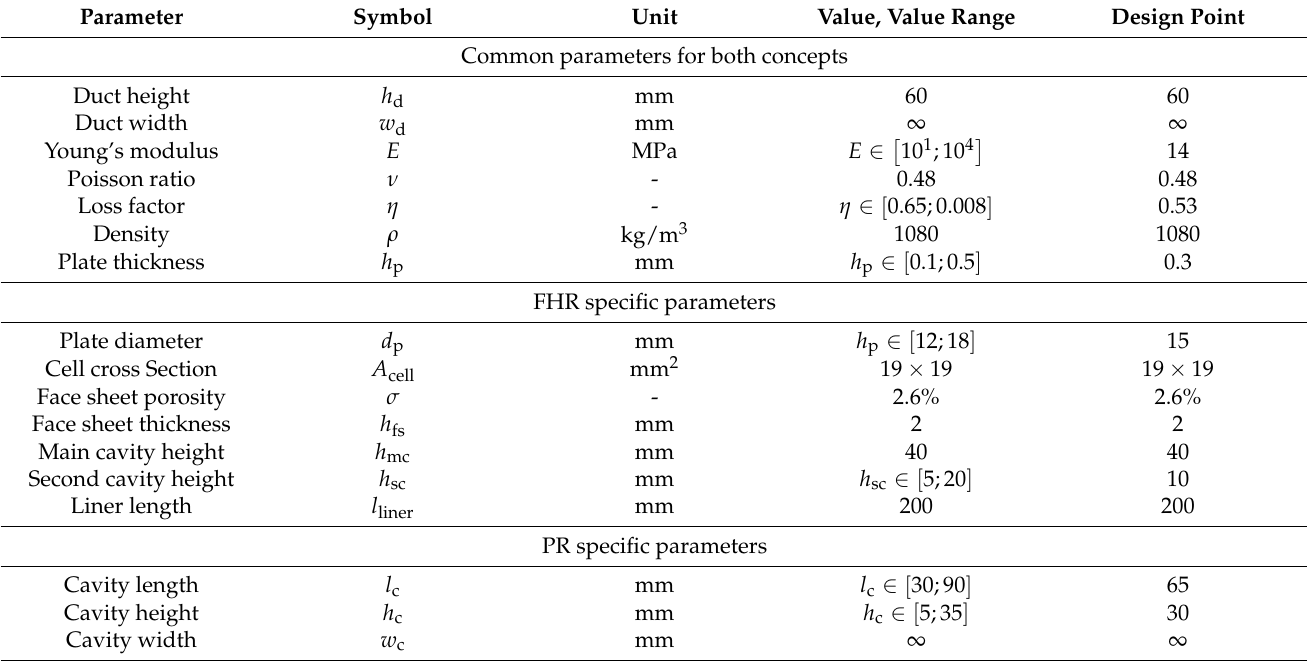
Table 2. Values of geometry and material